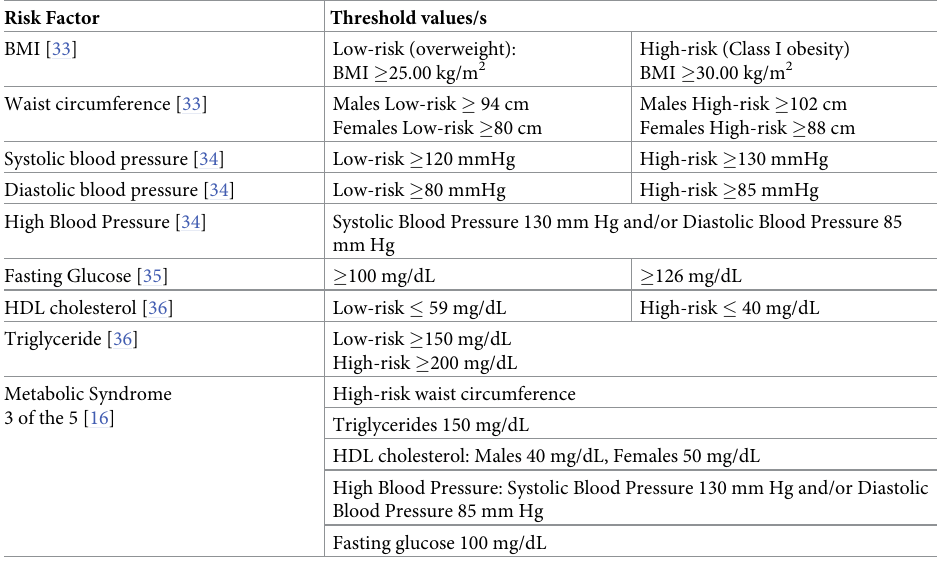
Table 1. Thresholds for different metabolic related health